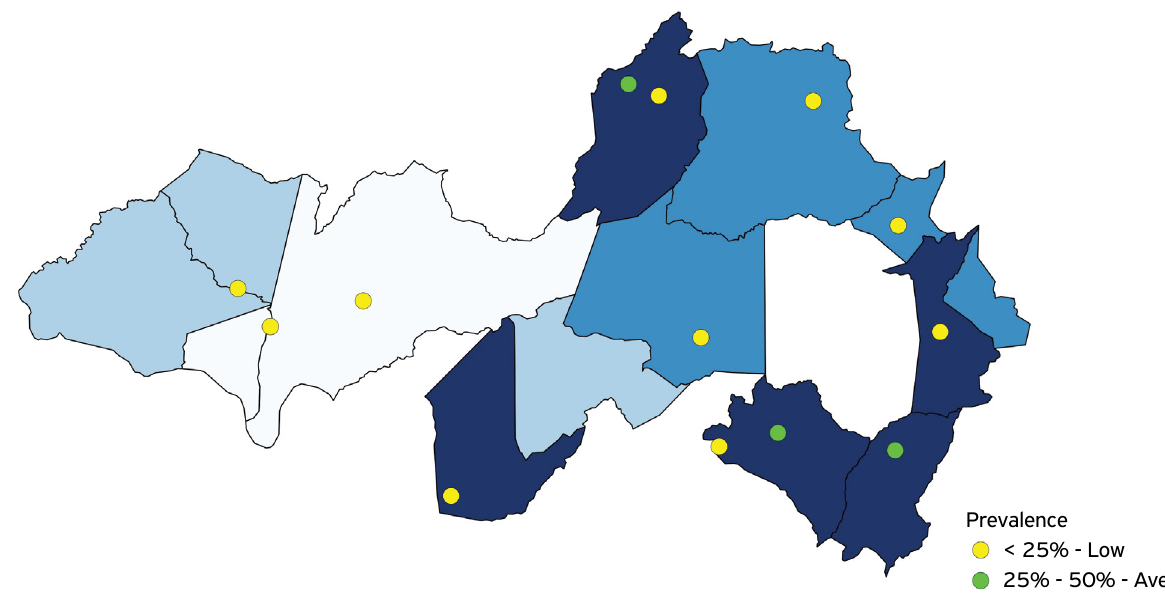
Figure 1. Prevalence of Leptospira spp. among sheep in Pernambuco state,